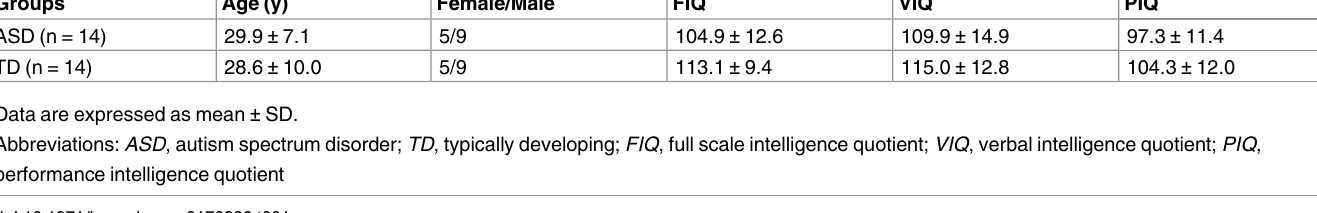
Table 1. Demographic characteristics of ASD and TD adults.